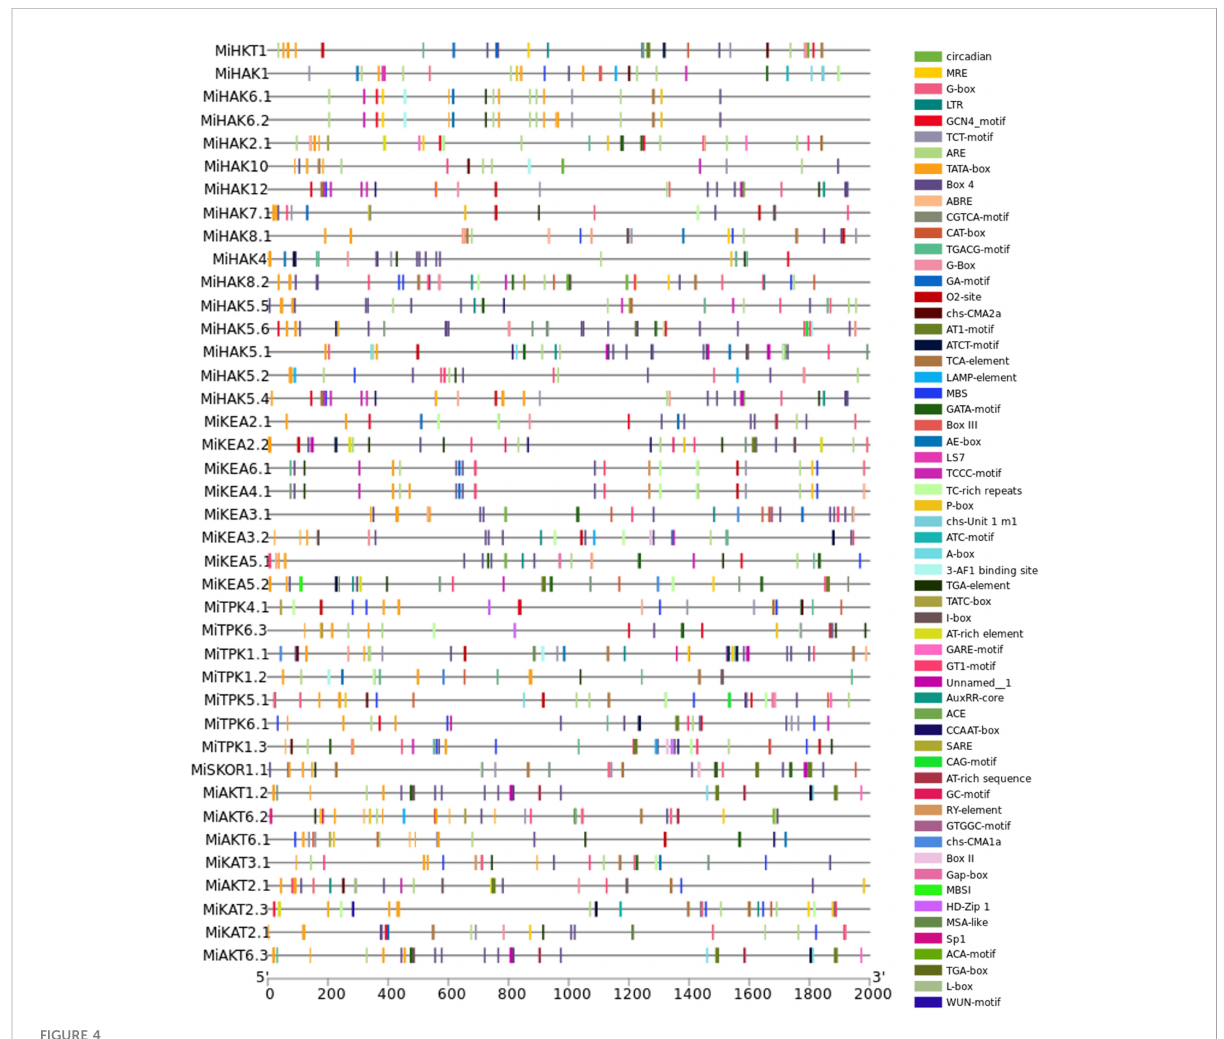
FIGURE 4 Cis -regulatory elements within 2,000-bp promoter region of